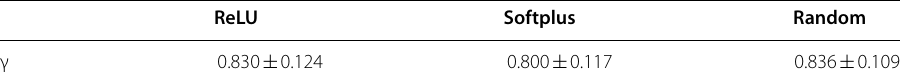
Table 2 The comparison of values of score margin for three compared structures of CNN ReLU